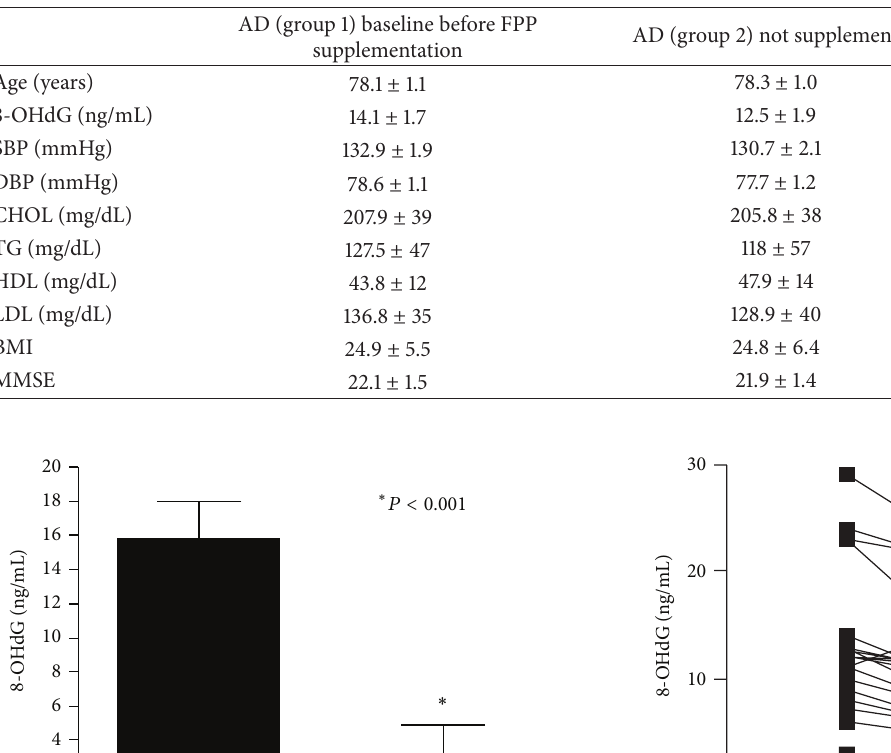
Table 1: Clinical characteristics of study patients.